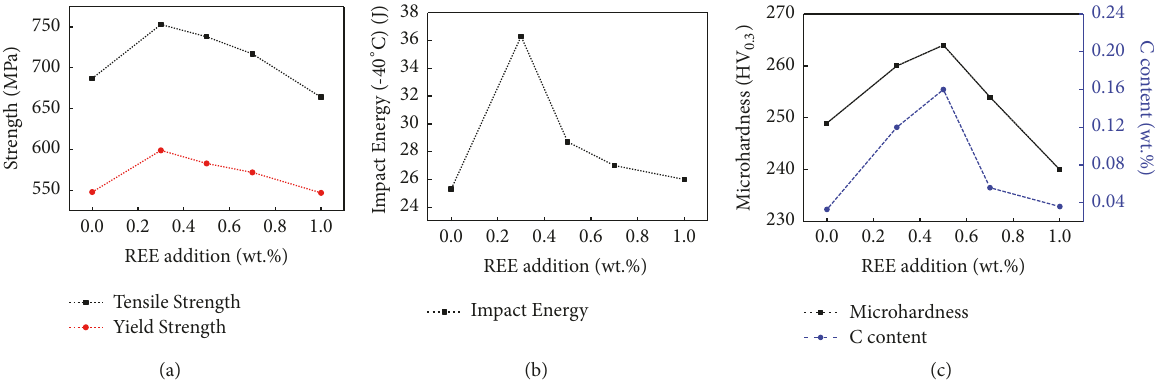
Figure 3: Mechanical properties of FCAW-welded metals for different REE contents: (a) tensile properties; (b) low-temperature impact toughness; and (c) microhardness.